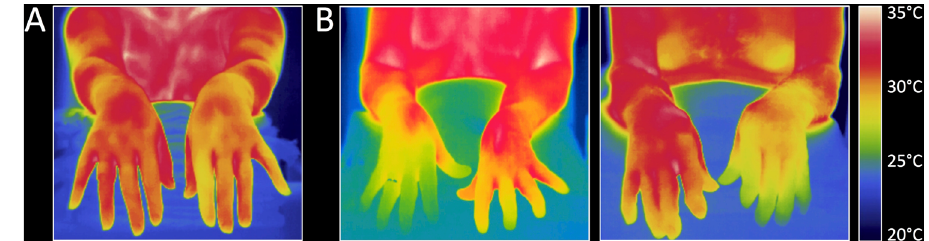
Fig. 5 Thermograms in a healthy control subject ( a ) and two patients with PD ( b ). Note the asymmetric hand temperature in the patients. [Figure provided at the courtesy of the Dr Antonio-Rubio and